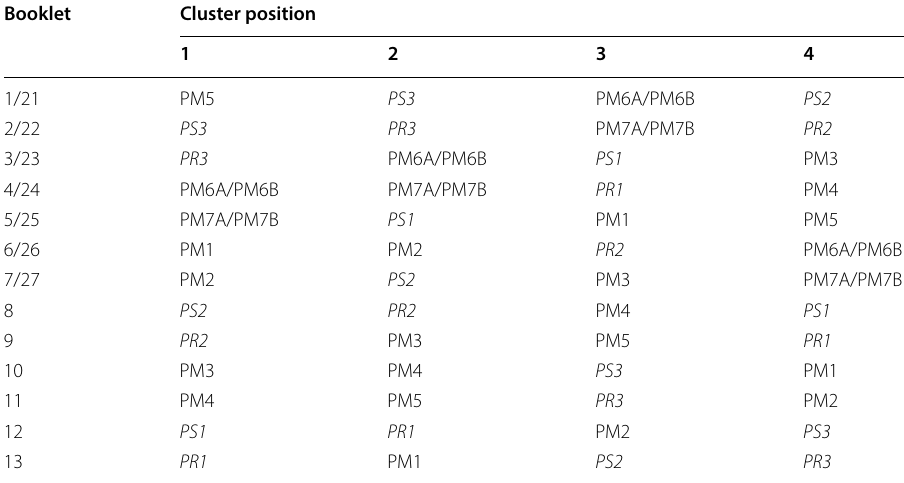
Table 2 Cluster rotation design of PISA